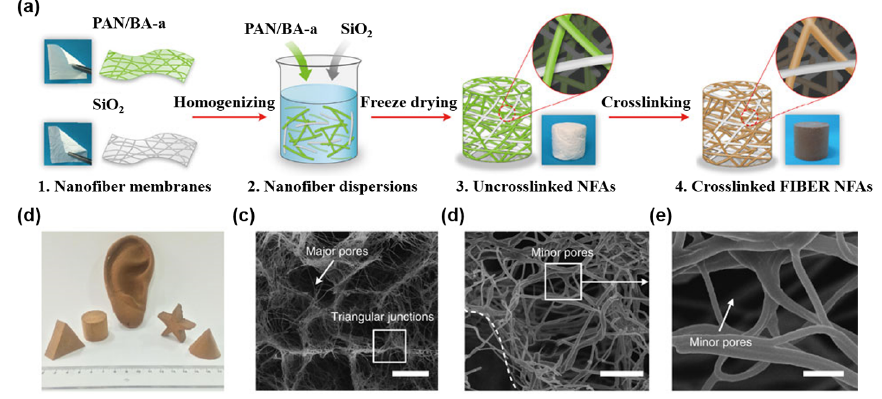
Figure 4. Design, processing and cellular architectures of FIBER nanofibrous aerogels. ( a ) Schematic showing the synthetic steps. (1) Flexible PAN/BA ‐ a and SiO 2 nanofiber membranes are produced by electrospinning. (2) Homogeneous nanofiber dispersions are fabricated via high ‐ speed homogenization. (3) Uncrosslinked nanofibrous aerogels (NFAs) are prepared by freeze drying nanofiber dispersions. (4) The resultant FIBER NFAs are prepared by the crosslinking treatment. ( b ) An optical photograph of FIBER NFAs with diverse shapes. ( c – e ) Microscopic architecture of FIBER NFAs at various magnifications, showing the hierarchical cellular fibrous structure. Reproduced with permission of [113] (Copyright Nature Publishing Group 2014).